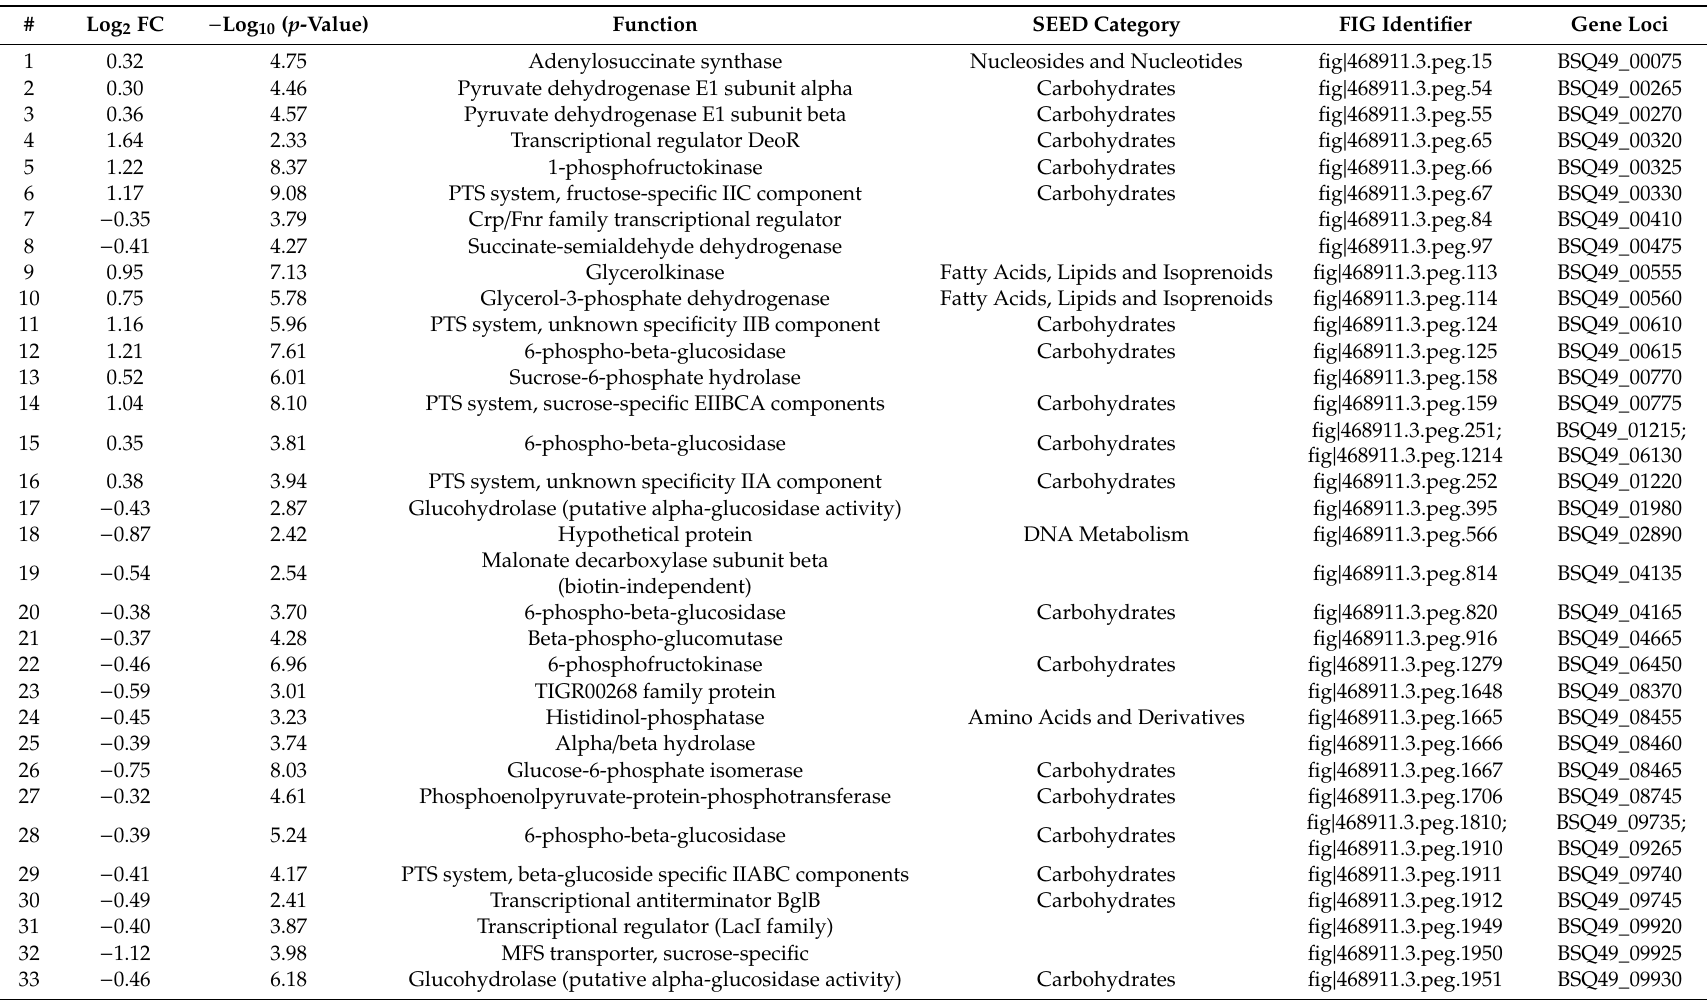
Table 1. Di ff erentially expressed proteins within cellular proteomes in the presence of sucrose compared to glucose. Positive log 2 FC values indicate up-regulated proteins in the presence of sucrose, while negative log 2 FC values indicate down-regulation in sucrose.